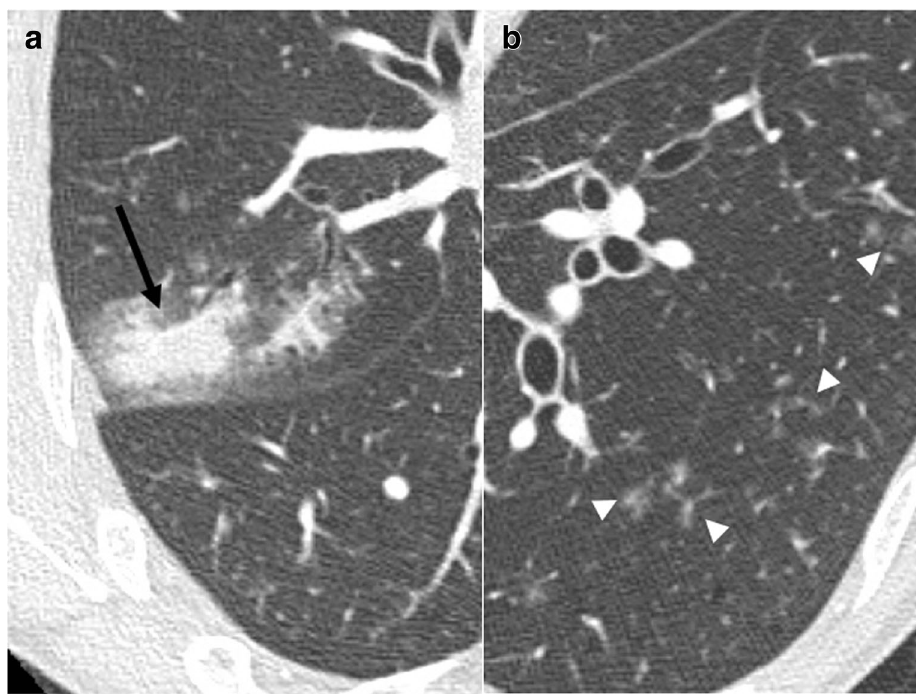
Fig. 18 Parainfluenzae pneumonia. Sepsis. Segmental consolidation of the right upper lobe ( arrow ) ( a ) and left basal ground-glass centrilobular micronodulation ( arrowheads ) ( b